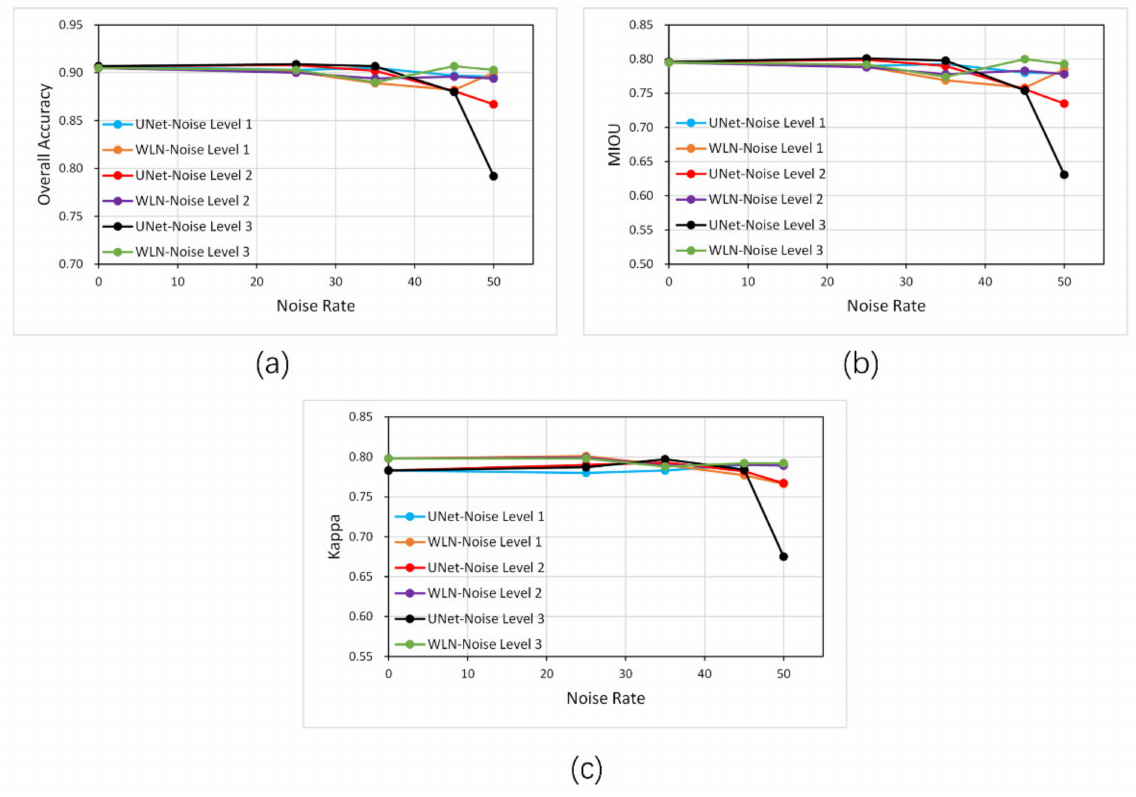
Figure 8. Accuracy plots of different dilated- noise rates and levels on the test set. ( a ) Overall accuracy, ( b ) MIOU and ( c ) Kappa.